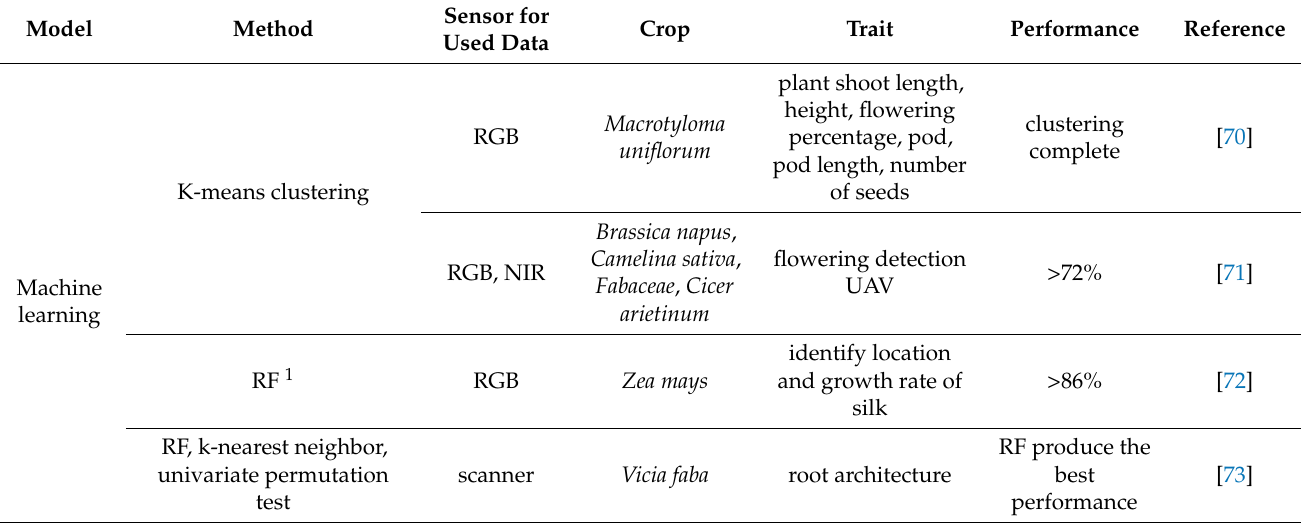
Table 2. Big data analysis technology using artificial intelligence